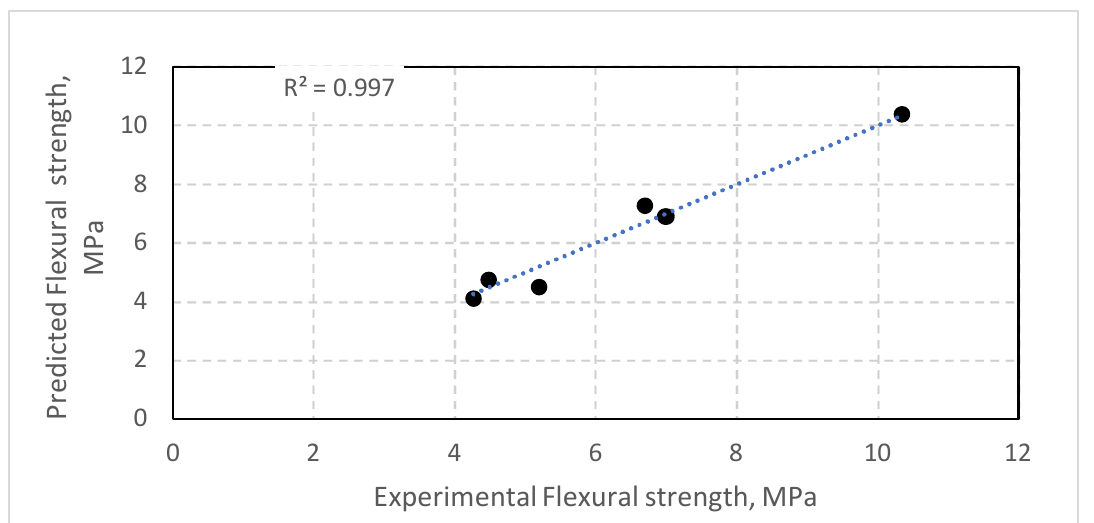
Figure 22. Comparison of predicted flexural strength to experimental flexural strength. Table 9. Values of β factors from the experimental test results.